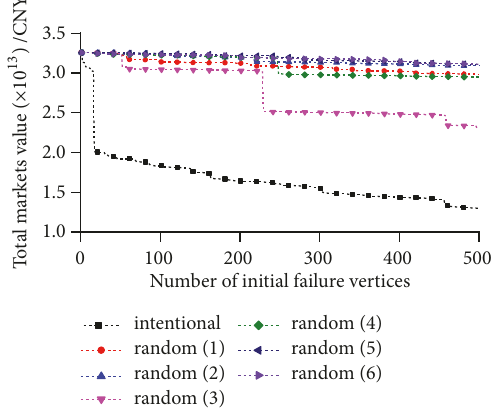
Figure 9: Relationships between the total markets value and the initial failure vertices in the